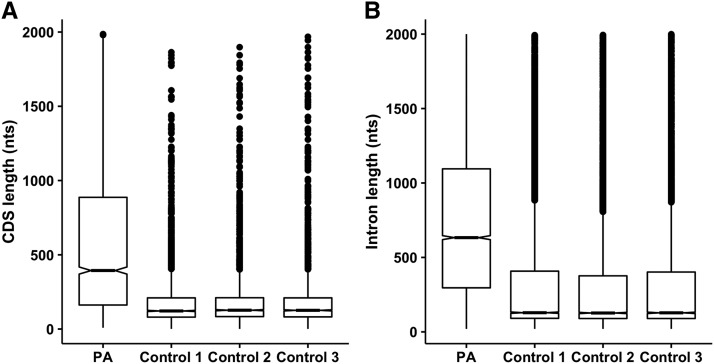
Difference in lengths of CDS and intronic regions with and without annotated PACs. CDS and introns with PACs (PA) were significantly longer in lengths than the lengths of those without annotated PACs (Control 1, Control 2, and Control 3). (A) CDS (one-tailed wilcoxon.test p-value = 2.2 × 10−16). (B) Introns (one-tailed wilcoxon.test p-value = 2.2 × 10−16).